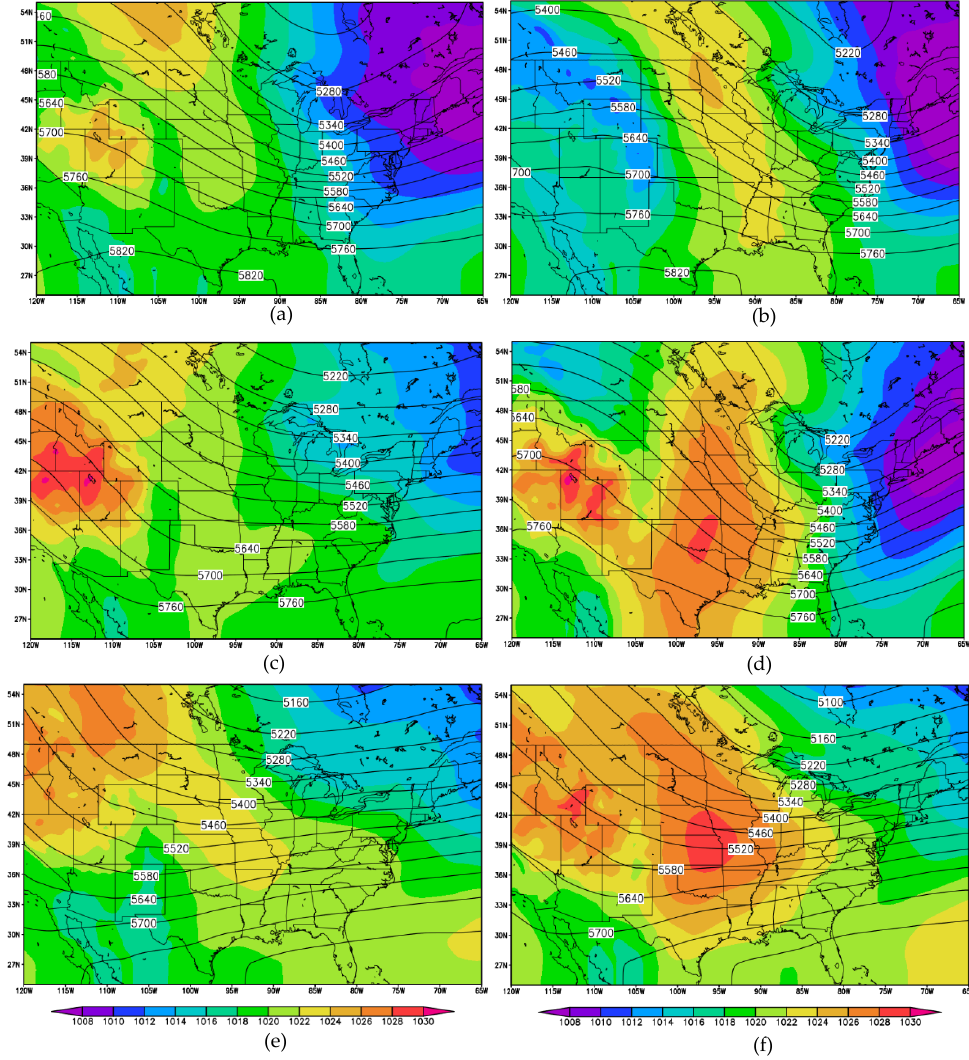
Figure 10 . 500 mb geopotential height (contours; m) and mean sea-level pressure (MSLP) (shaded; mb) composites at t = 0 h Figure 10. Lake Superior 500 mb geopotential height (contours; m) and mean sea-level pressure (MSLP) for Cluster 1 (a) , Cluster 2 (c) , and Cluster 3 (e) and t = 42 h for Cluster 1 (b) , Cluster 2 (d) , and Cluster 3 (f) . (shaded; mb) composites at t = 0 h for Cluster 1 ( a ), Cluster 2 ( c ), and Cluster 3 ( e ) and t = 42 h for Cluster 1 ( b) , Cluster 2 ( d ), and Cluster 3 ( f